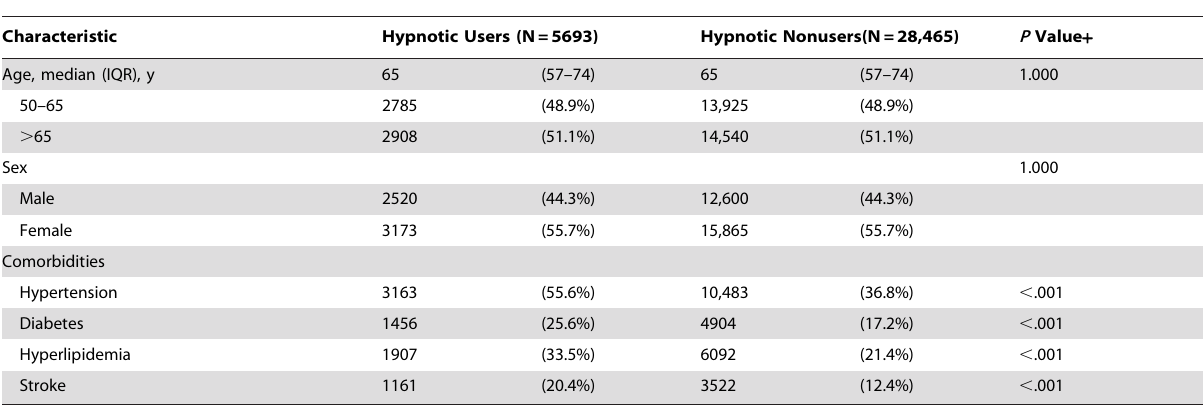
Table 1. Comparison of subjects with and without hypnotic use*.